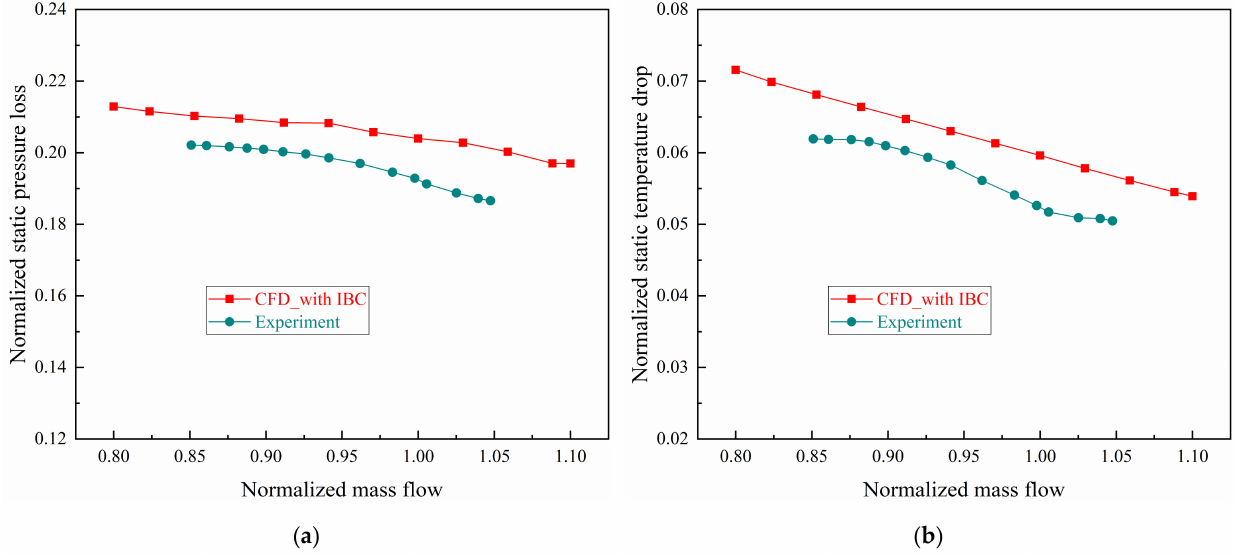
Figure 9. Predicted and measured radial p s loss and T s drop of IBC under design rotating speed: ( a ) static pressure loss; ( b ) static temperature